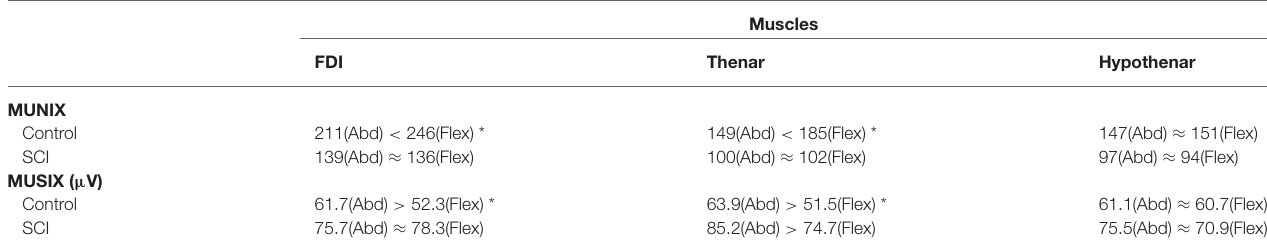
TABLE 1 | Direction dependence of MUNIX and MUSIX in FDI, thenar and hypothenar muscles of healthy control and SCI subjects; the mean value from all the examined muscles is presented